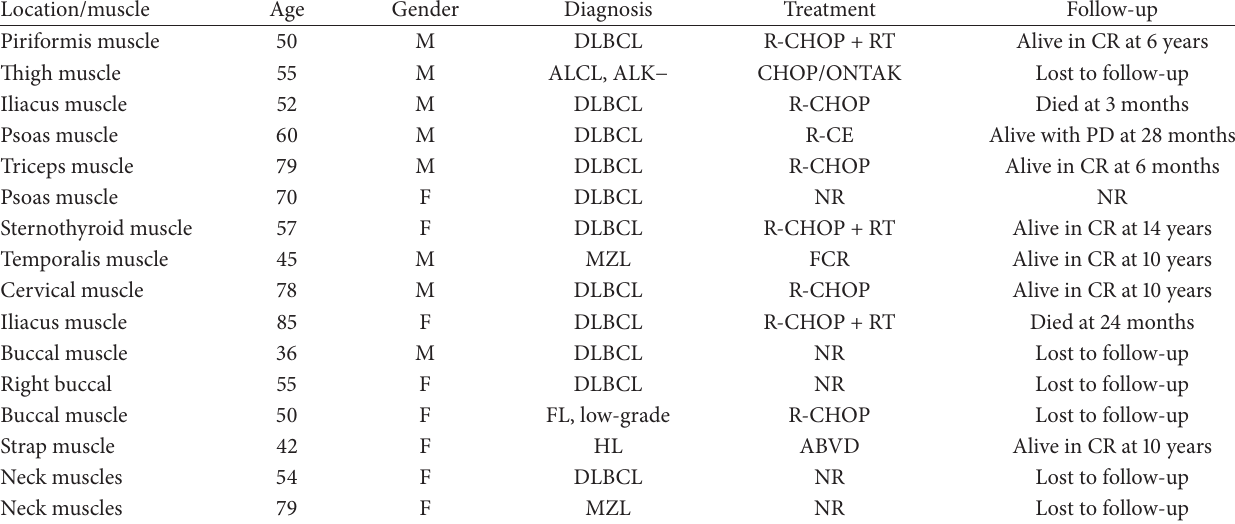
Table 1: Clinical characteristics, diagnosis, treatment, and follow-up in 16 patients with muscle lymphoma diagnosed at our institution between 2000 and 2015. Location/muscle Age Gender Diagnosis Treatment Follow-up